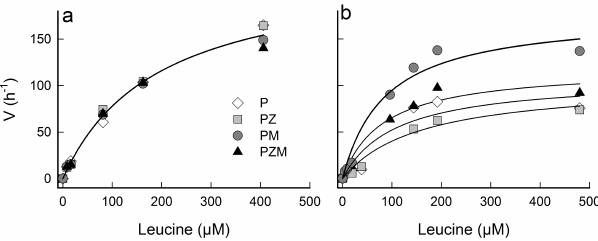
Fig. 9. Aminopeptidase activity in the background water of the tanks on days 0 (a) and 8 (b) as determined from the hydrolysis of leucine. The values of V max and K s for the curve shown in (a) are 227 ± 10h − 1 and 192 ± 18µM ( r 2 = 0 . 99). In (b) , the highest curve (the one for PM) has a V max of 177 ± 19h − 1 and a K s of 87 ± 28µM ( r 2 = 0 . 97), while the lowest curve (the one for PZ) has a V max of 103 ± 14h − 1 and a K s of 157 ± 50µM ( r 2 = 0 .